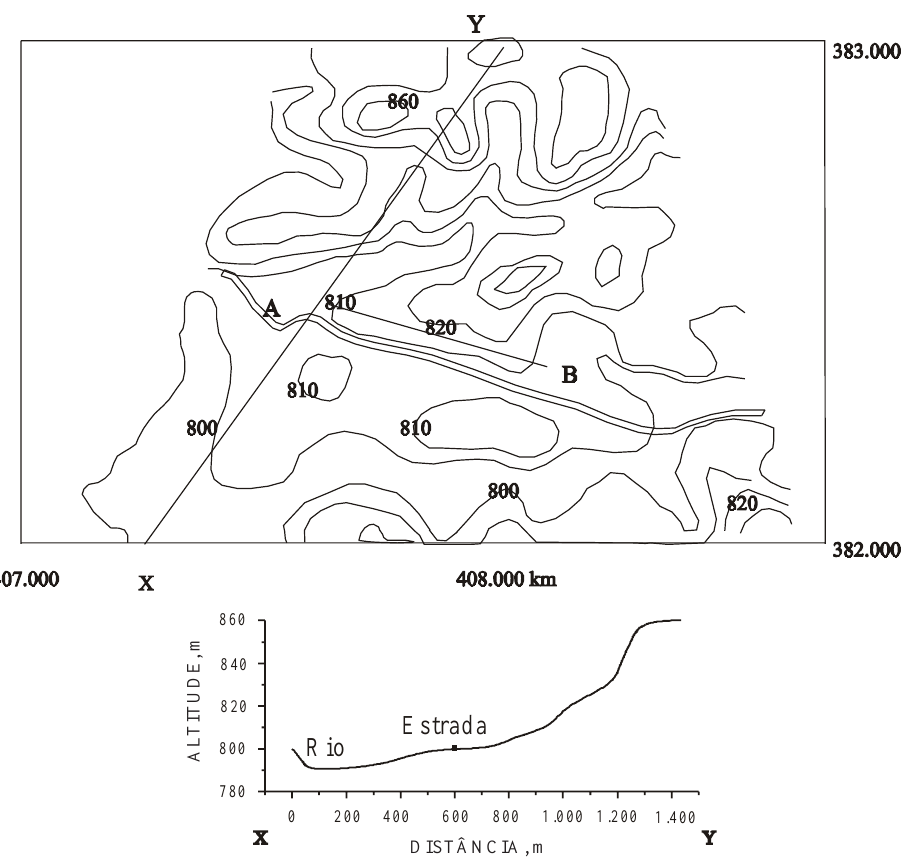
Figura 2. Representação do relevo local e localização da toposseqüência estudada. X – Y = perfil representativo do relevo local; A – B = toposseqüência